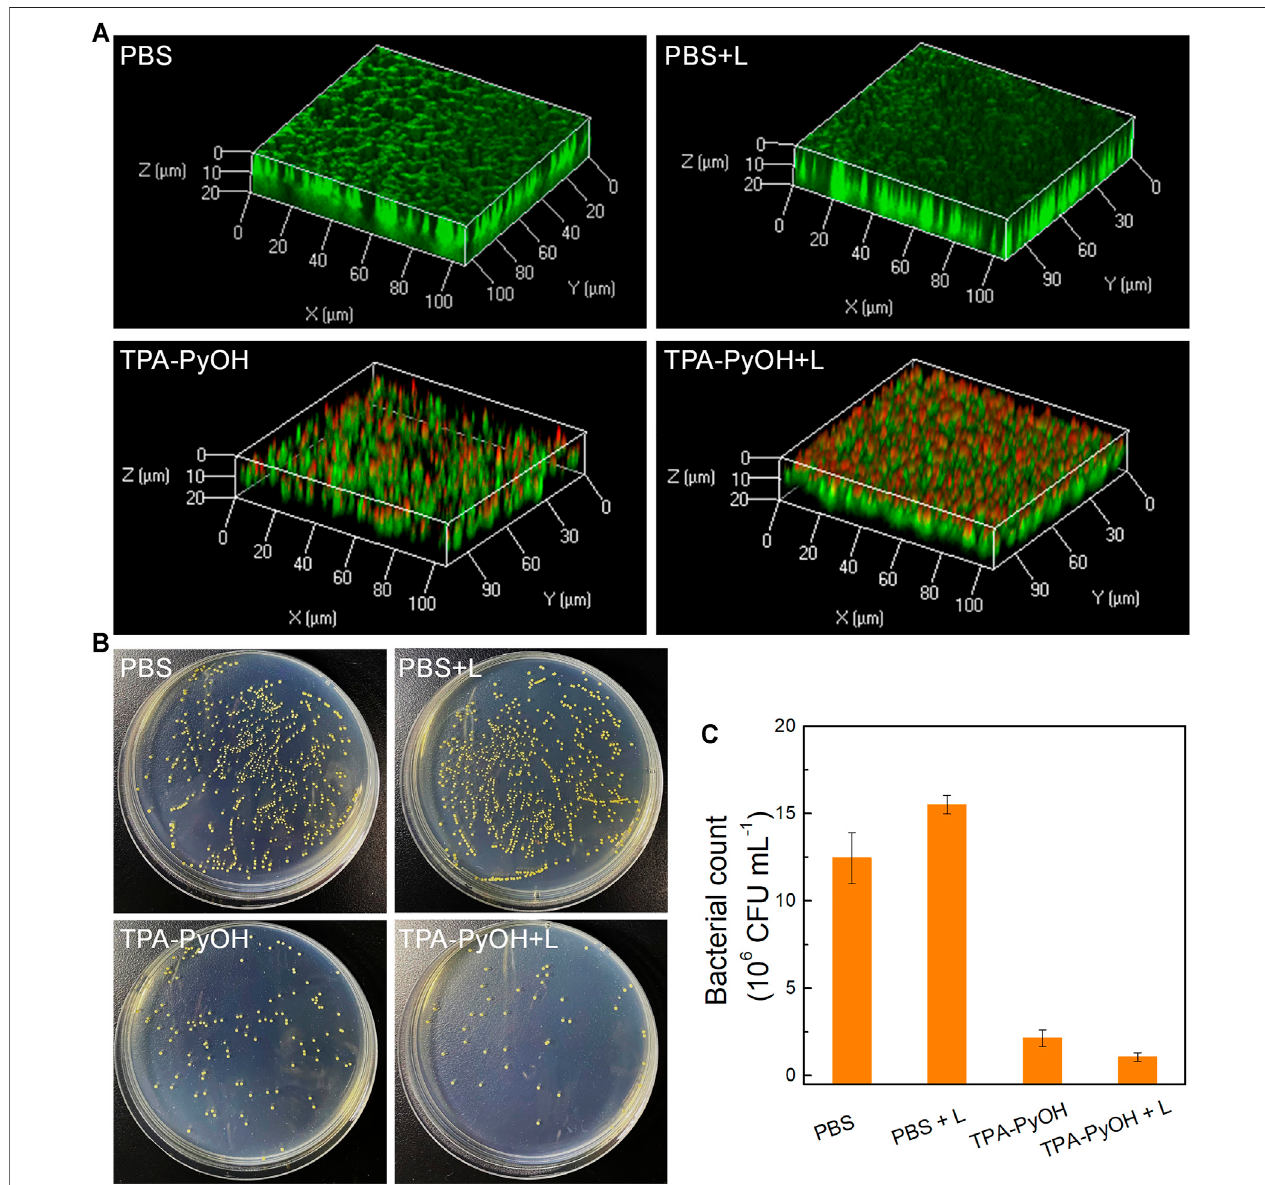
FIGURE7 |(A) The merged fl uorescence images of S. aureus bio fi lmsupondiversetreatments.The whole bio fi lmwasco-stained bySYTO-9 (green channel)and PI (red channel); (B) Representative plate photographs of S. aureus colonies upon diverse treatments; (C) Number of viable S. aureus bacterial count after different